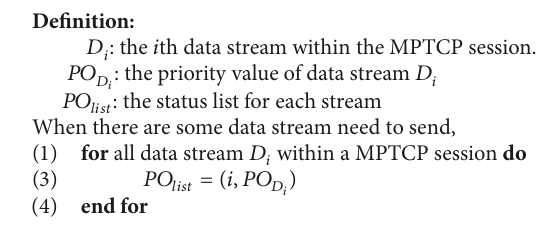
Algorithm 1: DPAM-based priority information collection algo- rithm.